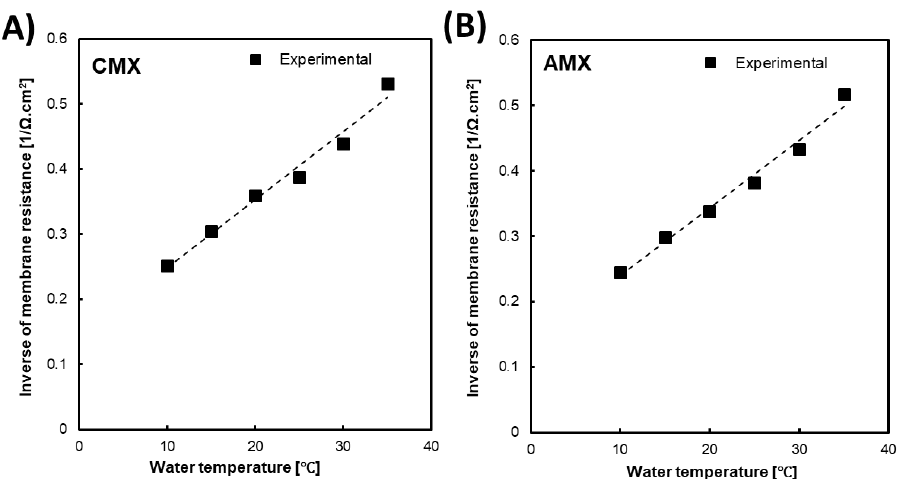
Figure 3. The effect of water temperature on the inverse values of the membrane resistance of CMX ( A ) and AMX ( B ).